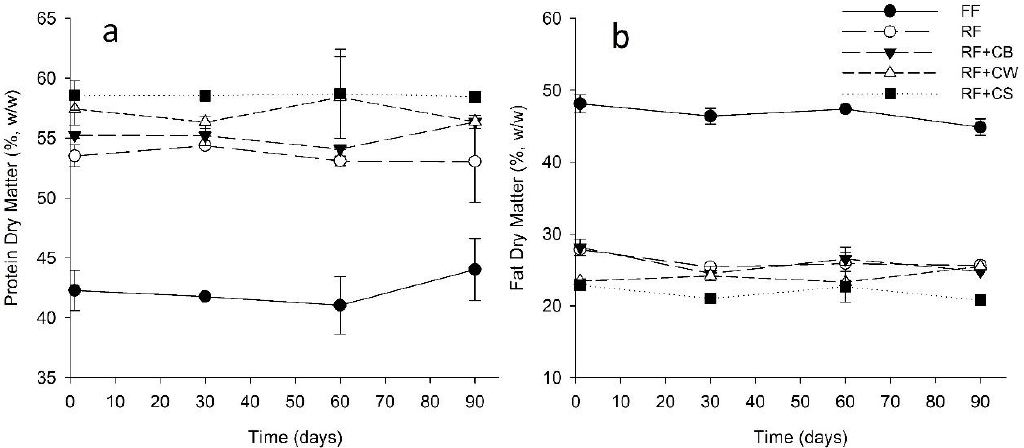
Figure 2. Protein in dry matter ( a ) and fat in dry matter (FDM) ( b ) of tested cheeses over ripening. (FF): full-fat; (RF): reduced-fat; (RF + CB): reduced-fat with concentrated buttermilk; (RF + CW): reduced-fat with concentrated whey; (RF + CS): reduced-fat with concentrated second cheese whey.